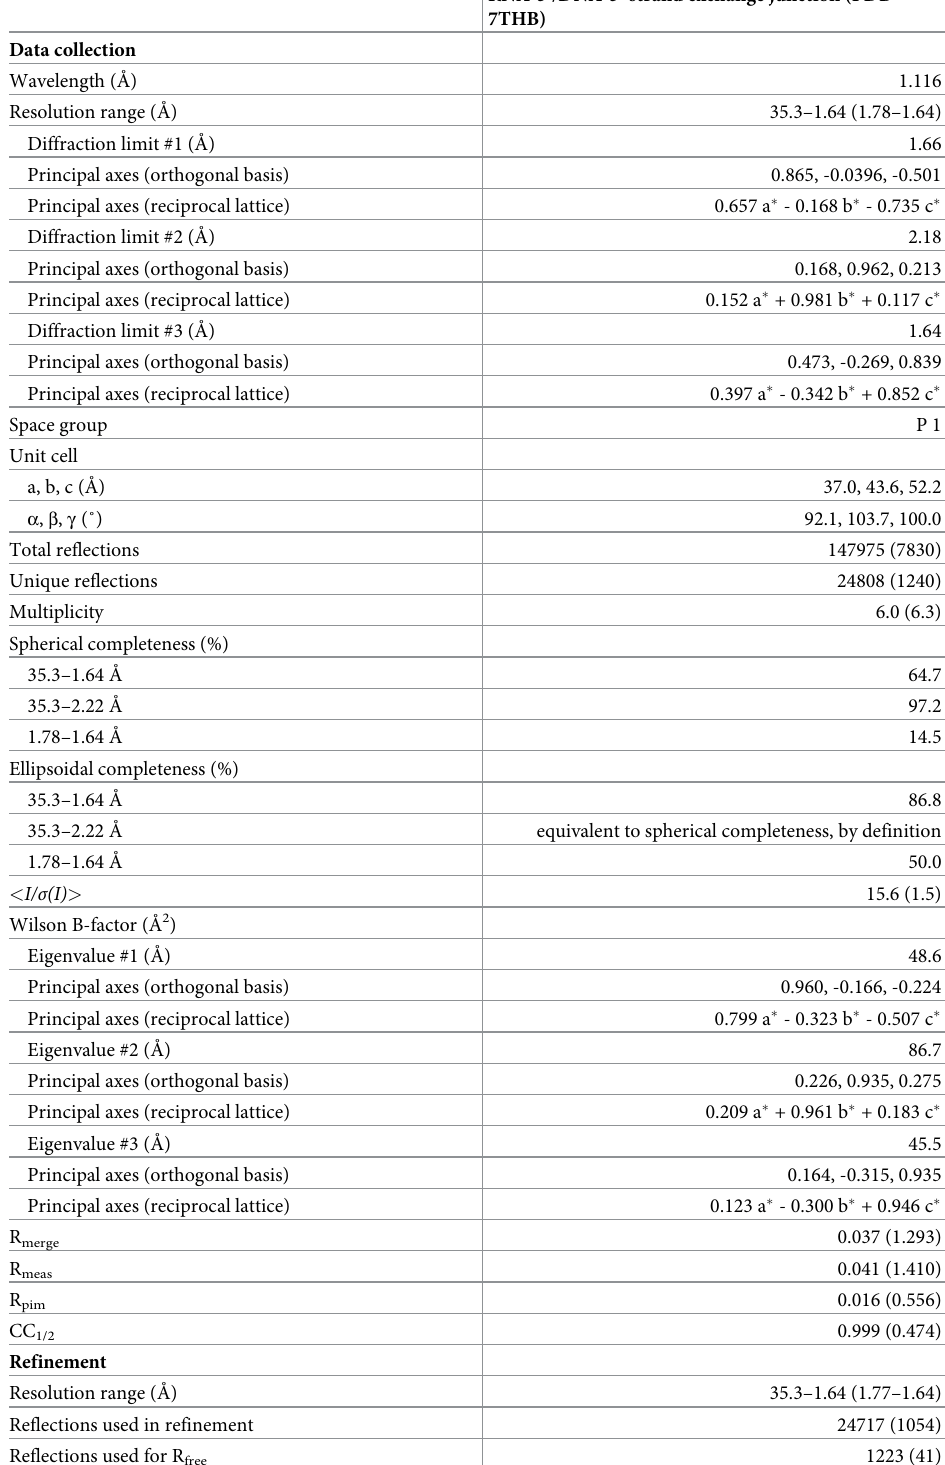
Table 1. Crystallographic data and refinement